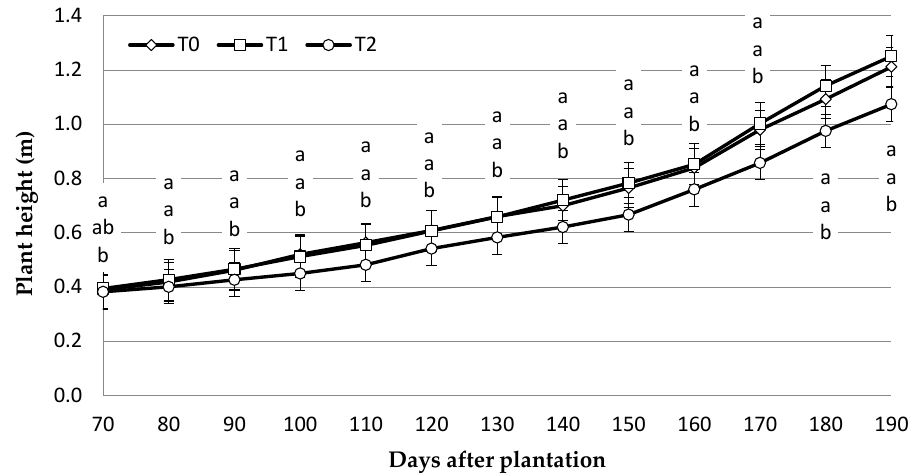
Figure 1. Plant height evolution according to the cuttings’ type used for the artichoke vegetative propagation. Within the same period, data were analyzed by ANOVA, and values with no letter in common are significantly different at p < 0.05 according to Tukey HSD Test. Standard errors are reported. T0: summer ovoli; T1: spring offshoots nursery’s cuttings forced to pass a vegetative rest period by stopping irrigation; T2: spring offshoots nursery’s cuttings not forced. 0.40.60.811.21.41.61.8